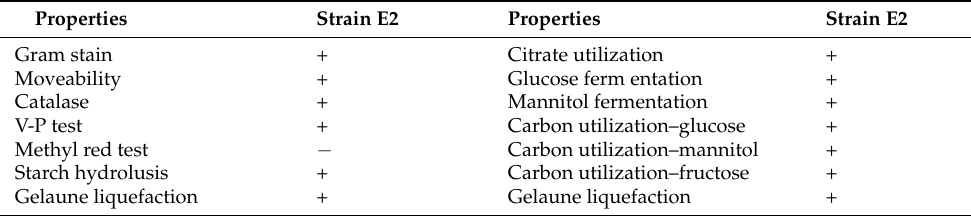
Figure 1. Inhibitory effect of strain E2 on A. flavus using cup–disc ( A ), Gram staining results of N2 and its morphology ( B ). Table 2. Physiological and biochemical properties of strain